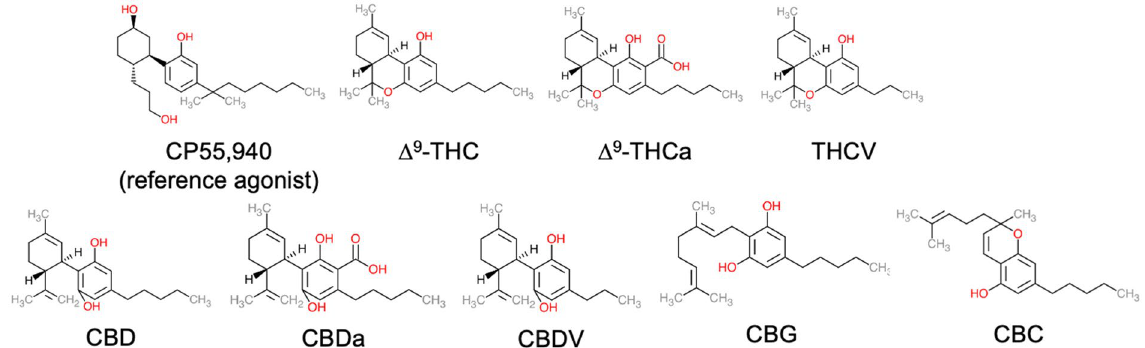
Figure 1. Cannabinoids assessed in this study. Chemical structures were drawn in Microsoft PowerPoint by the authors.